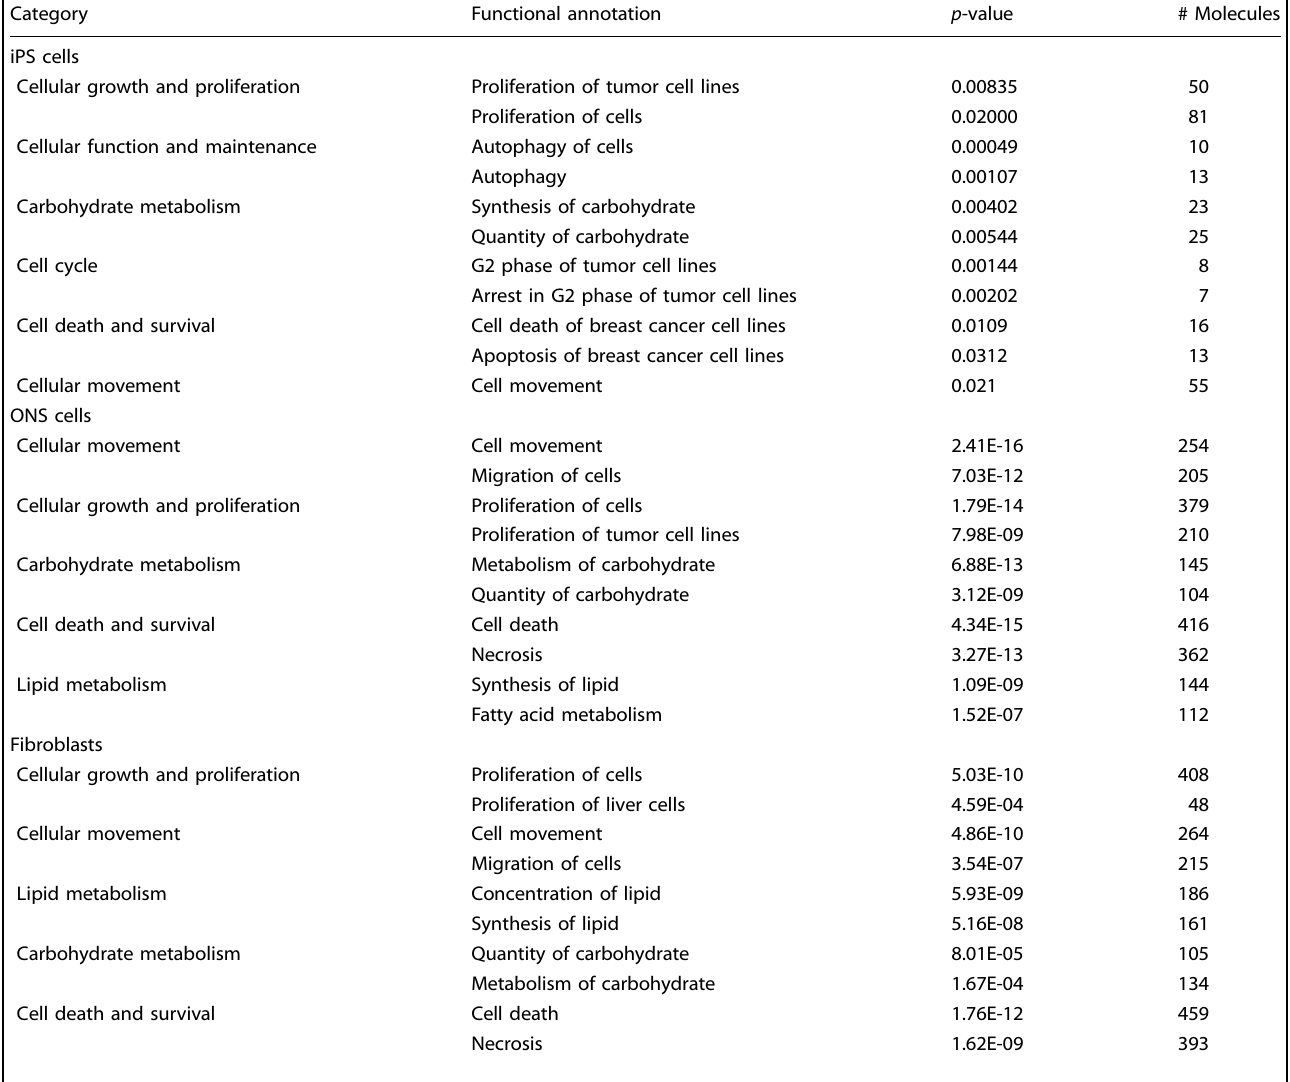
Table 1. GO categories of genes differentially methylated between patients and controls (top categories ranked according to p -value)